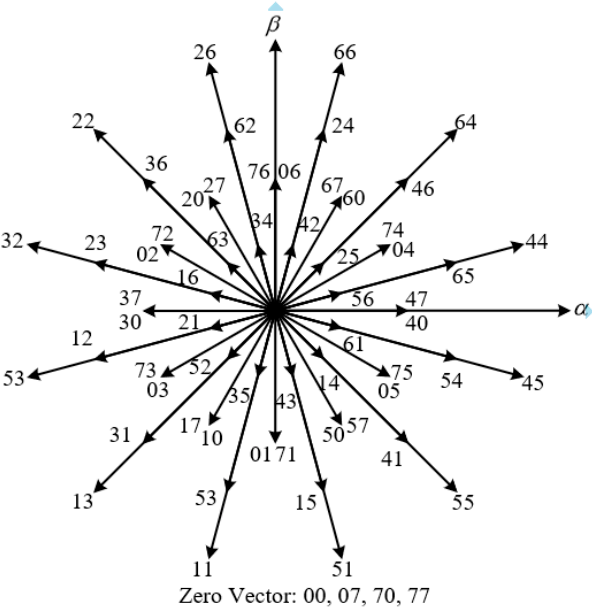
Figure 3. Voltage vector distribution in the α − β